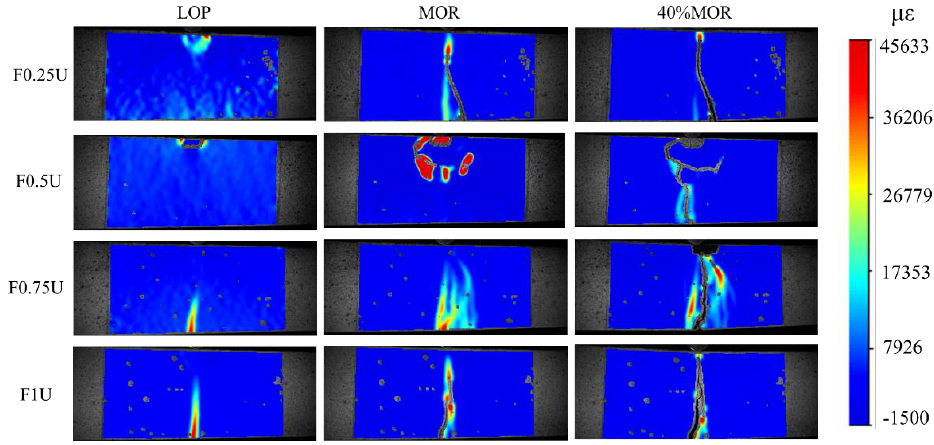
Figure 8. Crack patterns and strain distribution of specimens under different loads.